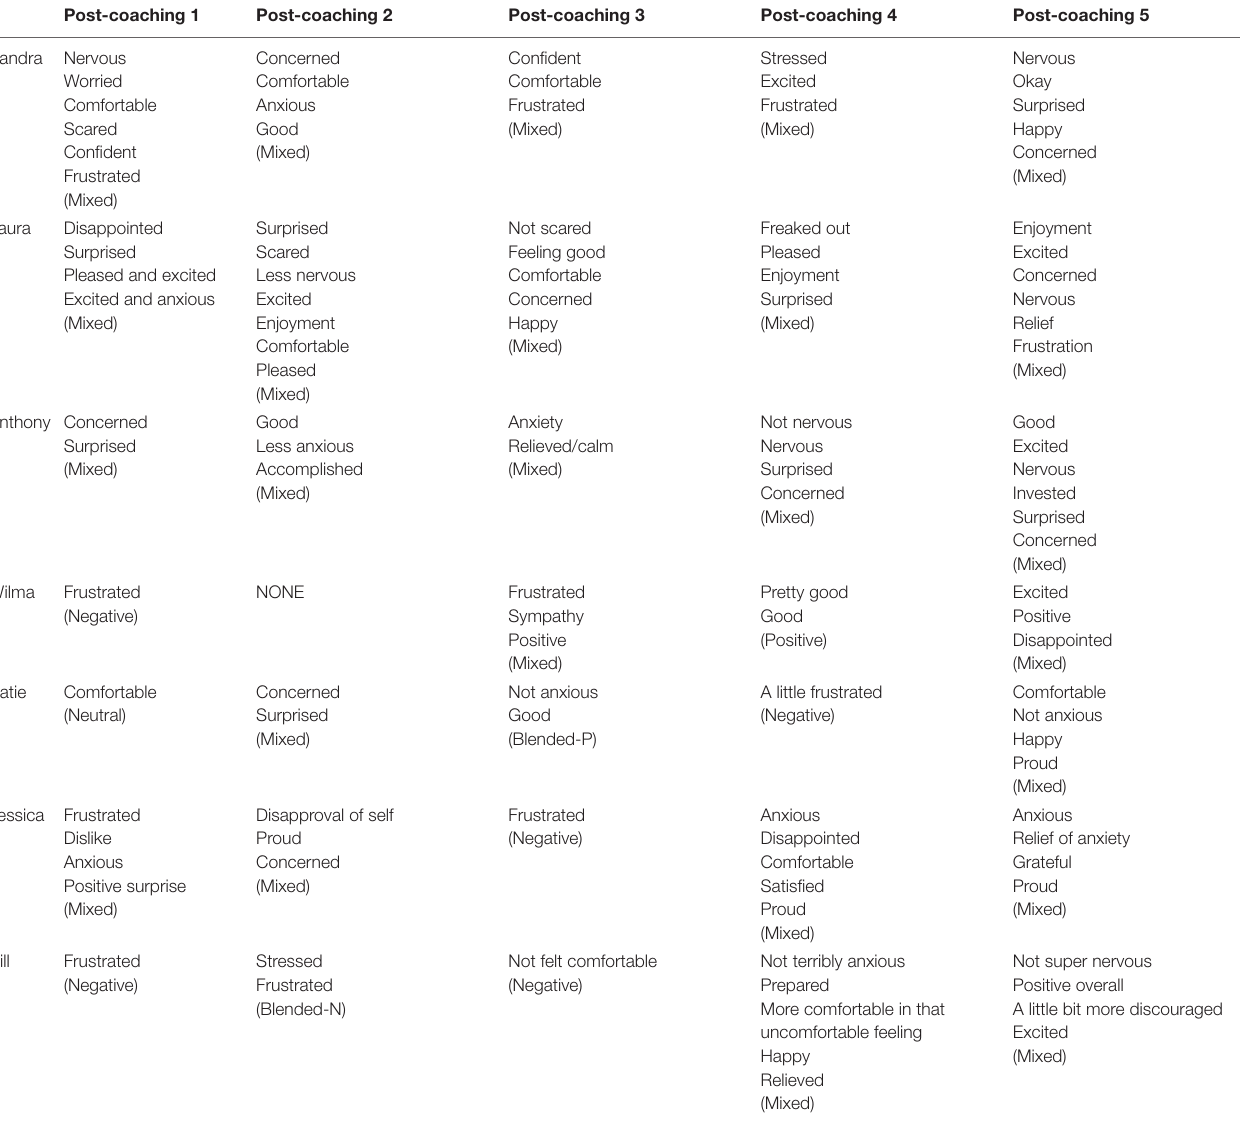
TABLE A1 | Teachers’ descriptions of their emotions during the post-coaching